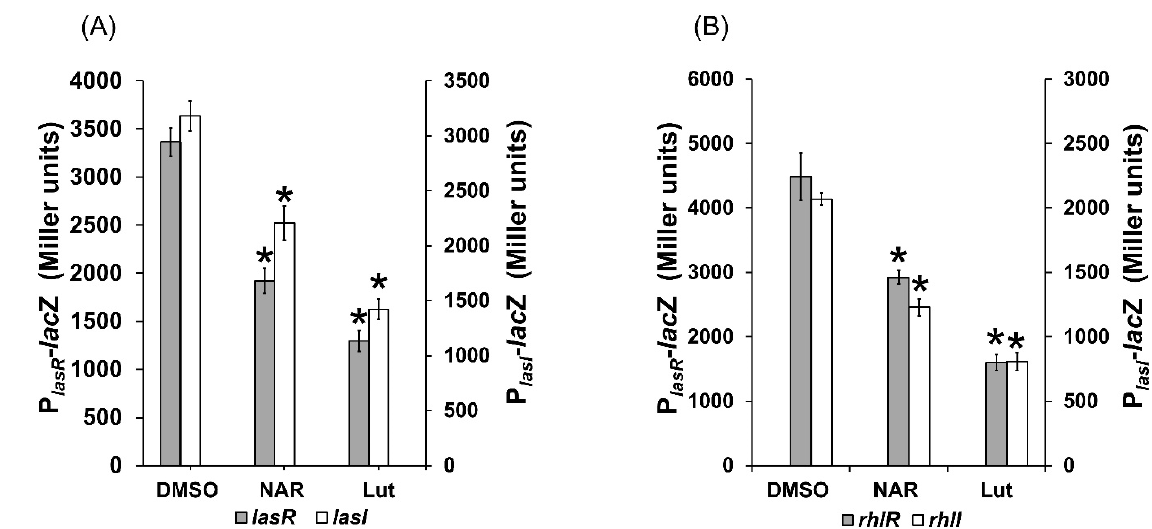
Figure 8. Effect of Lut on the expression of PAO1 QS-regulated lasB and rhlA and the QS-independent aceA after 18 h of incubation. ( A ) Effect of Lut at 22 µM on lasB expression. ( B ) Effect of Lut on rhlA expression. ( C ) Effect of Lut on aceA gene expression. Gene expression was measured as the β -galactosidase activity of the lacZ gene fusions and expressed in Miller units. Naringenin (NAR) was used as a QS inhibitor control and DMSO as a negative control. Error bars represent SEM, and all experiments were performed in quintuplicate with three independent assays; asterisks indicate samples that were significantly different from the DMSO ( p ≤ 0.01).